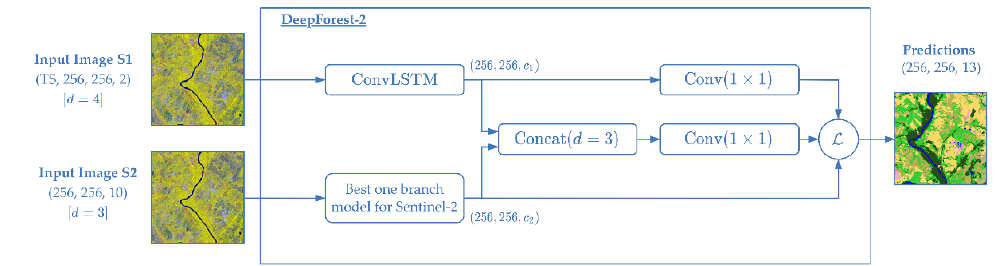
Figure 5. The architecture of the two ‐ branch model DeepForest ‐ 2. For the multispectral stream, a prior learned classifier was used; i.e., DeepLab or one of the DeepForest ‐ 1 model variations.